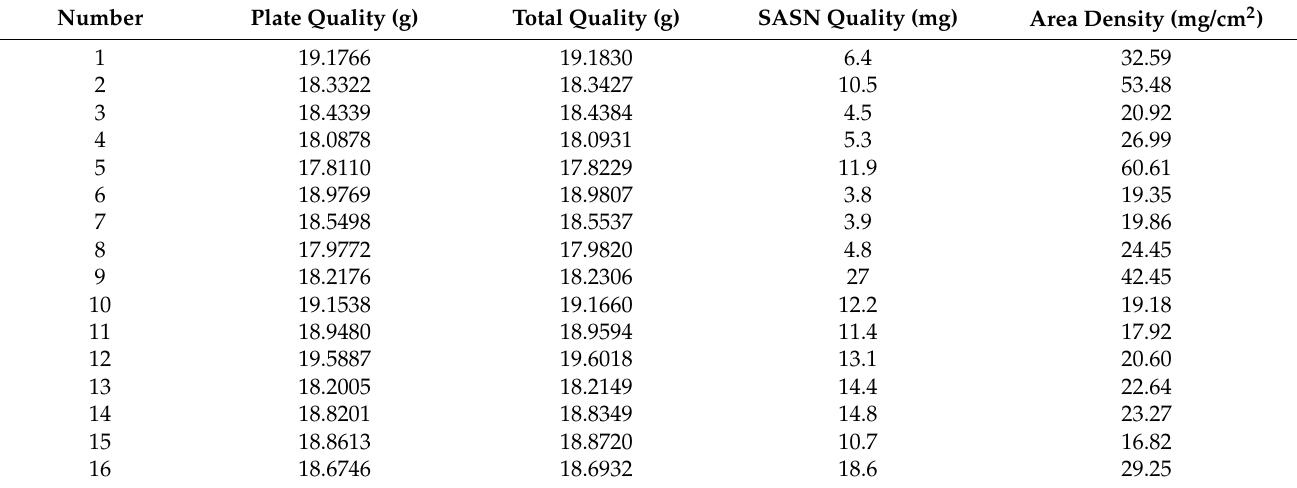
Table 4. Experimental parameter of initiation of different